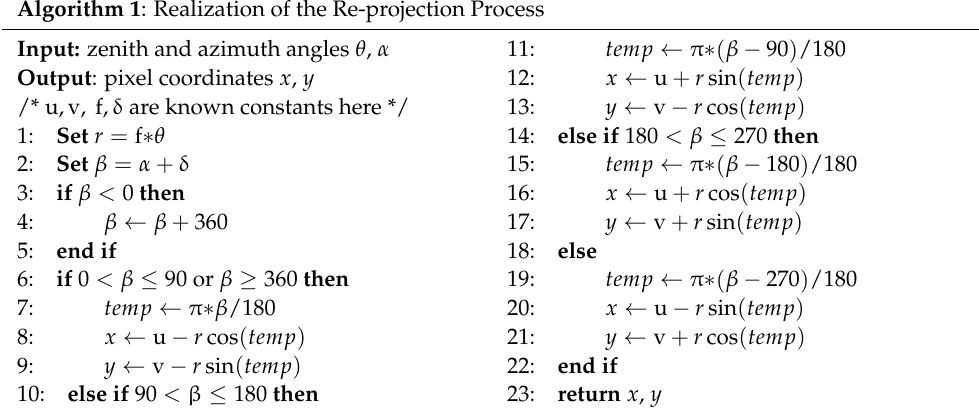
Algorithm 1 : Realization of the Re-projection